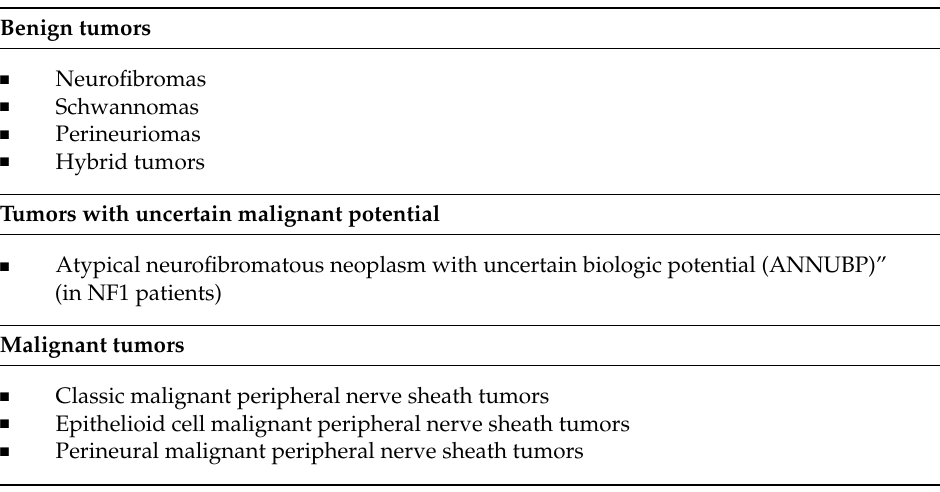
Table 1. Classification of the peripheral nerve sheath